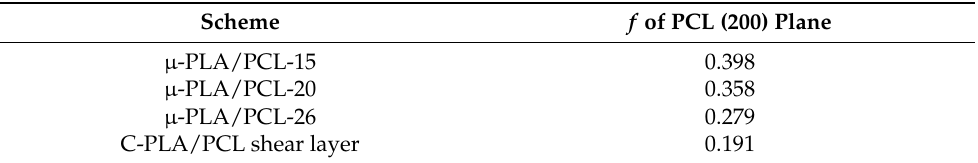
Table 4. The orientation parameter f of microparts with different cavity size and shear layer of